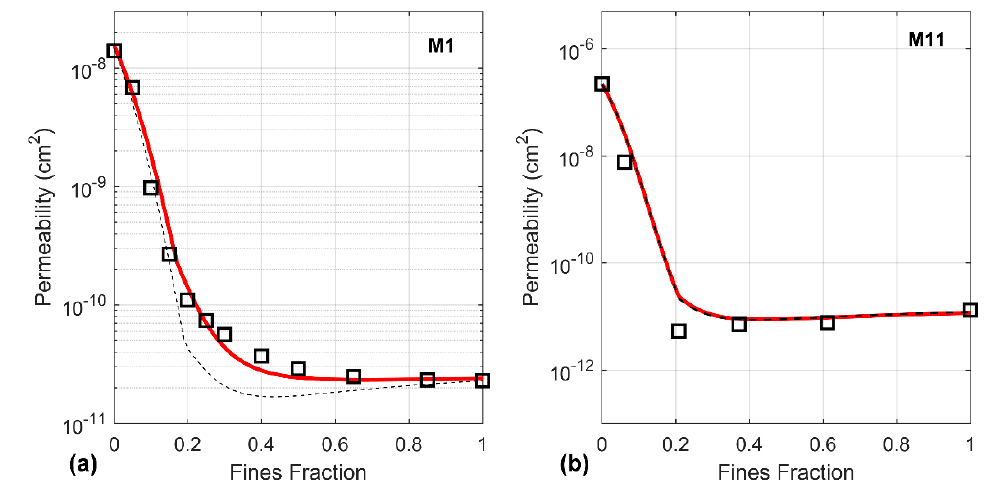
Figure 9. Permeability as function of fines fraction for mixtures: ( a ) M1, ( b ) M11. Same mixtures described in Table 1. K prediction was done using Equations (8)–(10) considering current model to estimate n (red solid curve) or ideal packing (dashed black curve).